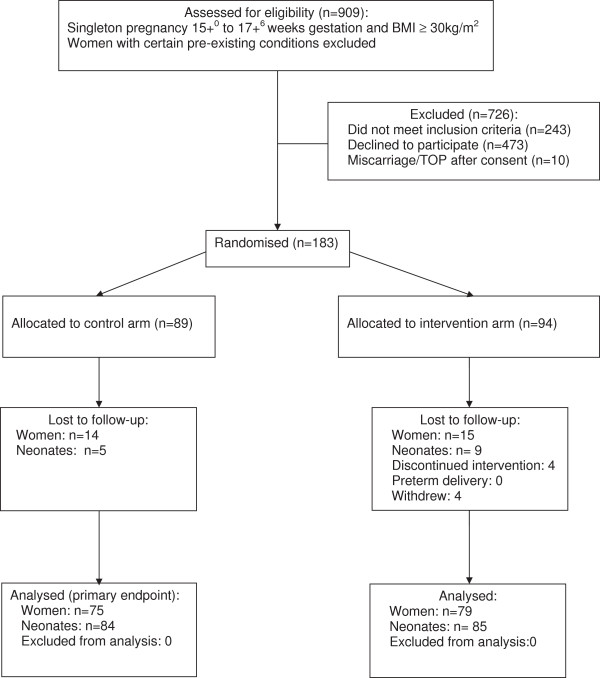
Consort Diagram. Flow chart of participants through study.